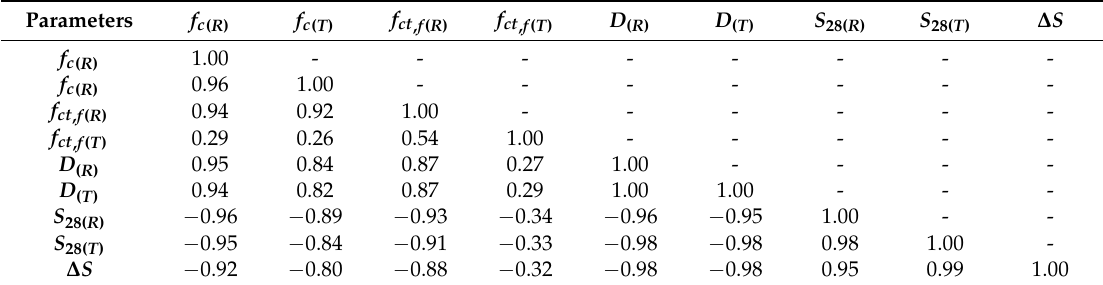
Table 6. Correlation matrix of the parameters examined of the cement